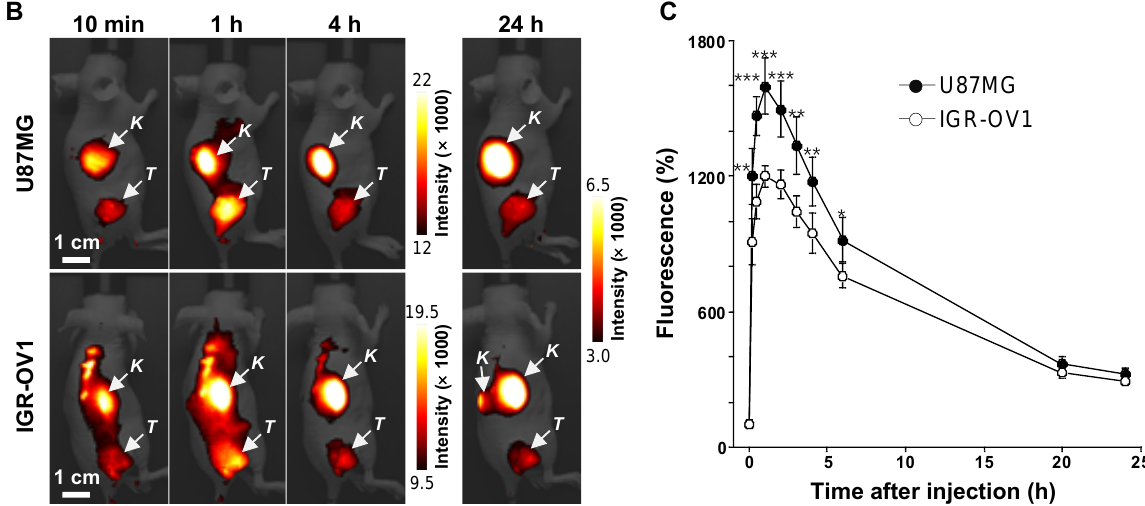
Figure 1. In vivo near-infrared fluorescence (NIRF) imaging. ( A ) The amino acid sequence of pHLIP and fluorescence labeling at the N-terminal side. AF546-pHLIP, Alexa Fluor™ 546 fluorescent dye- conjugated pHLIP; IR800-pHLIP, IRDye ® 800CW NIR fluorescent dye-conjugated pHLIP. ( B , C ) NIRF imaging of mice bearing U87MG or IGR-OV1 subcutaneous tumors using IR800-pHLIP (5 nmol, intravenous injection). The images were acquired pre- and at 10 min, 30 min, 1 h, 2 h, 3 h, 4 h, 6 h, and 24 h post-injection. ( B ) Representative images. K , kidney; T , tumor. ( C ) Tumor fluorescence intensity over time. Fluorescence (%), percentage of the pre-injection signal intensity. Data are expressed as mean ± standard deviation ( n = 5/group). * p 0.05, ** p 0.01, and *** p 0.001 vs. IGR- OV1.